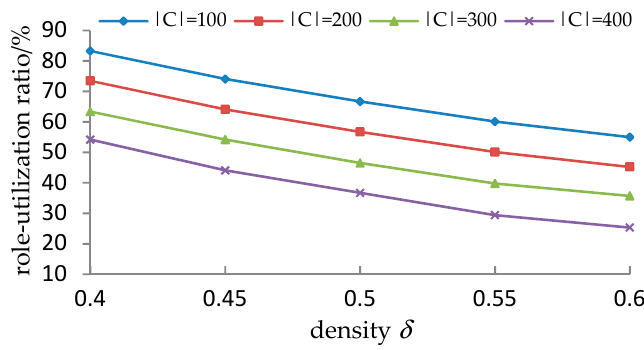
Figure 8. Performance of our method with different δ values.